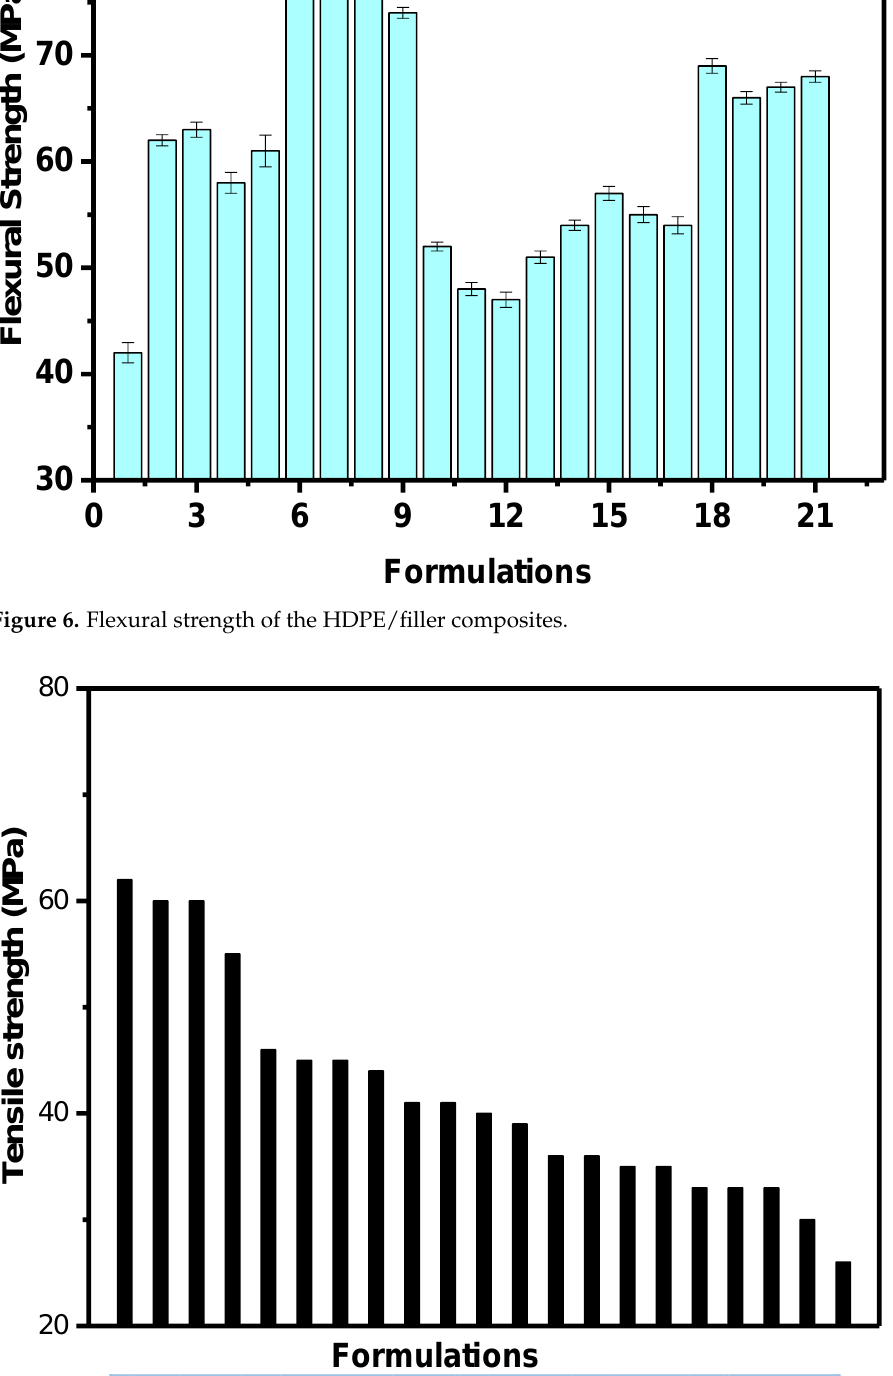
Figure 6. Flexural strength of the HDPE/filler composites.